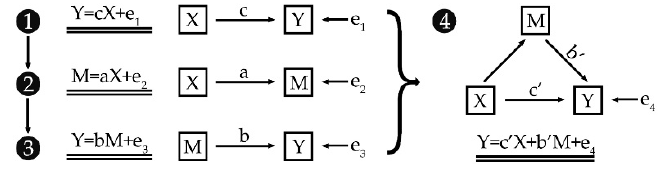
Figure 4. The classical mediating effect model.